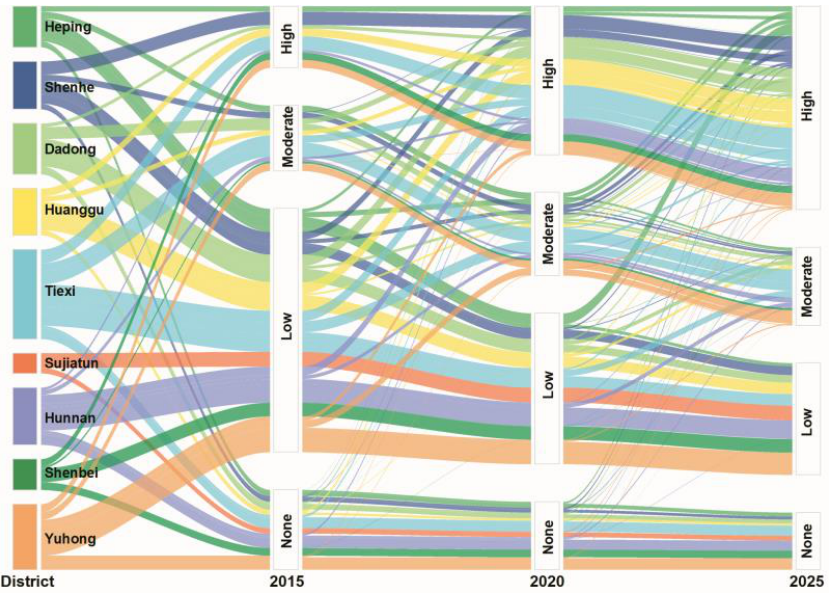
Figure 9. Spatial changes in residential zones with walking accessibility ranking.